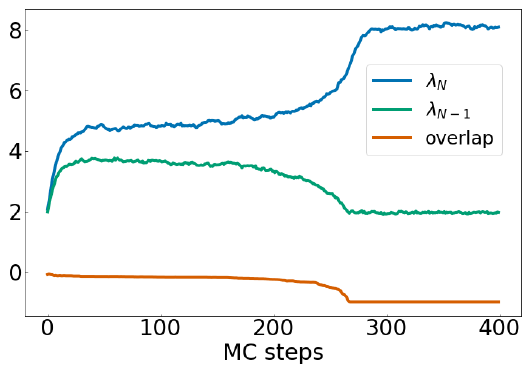
Figure 4: A run with two replicas at temperature β 1 = β 2 = 4 for p = 2. We show the first two eigenvalues and the overlap between the two replicas.